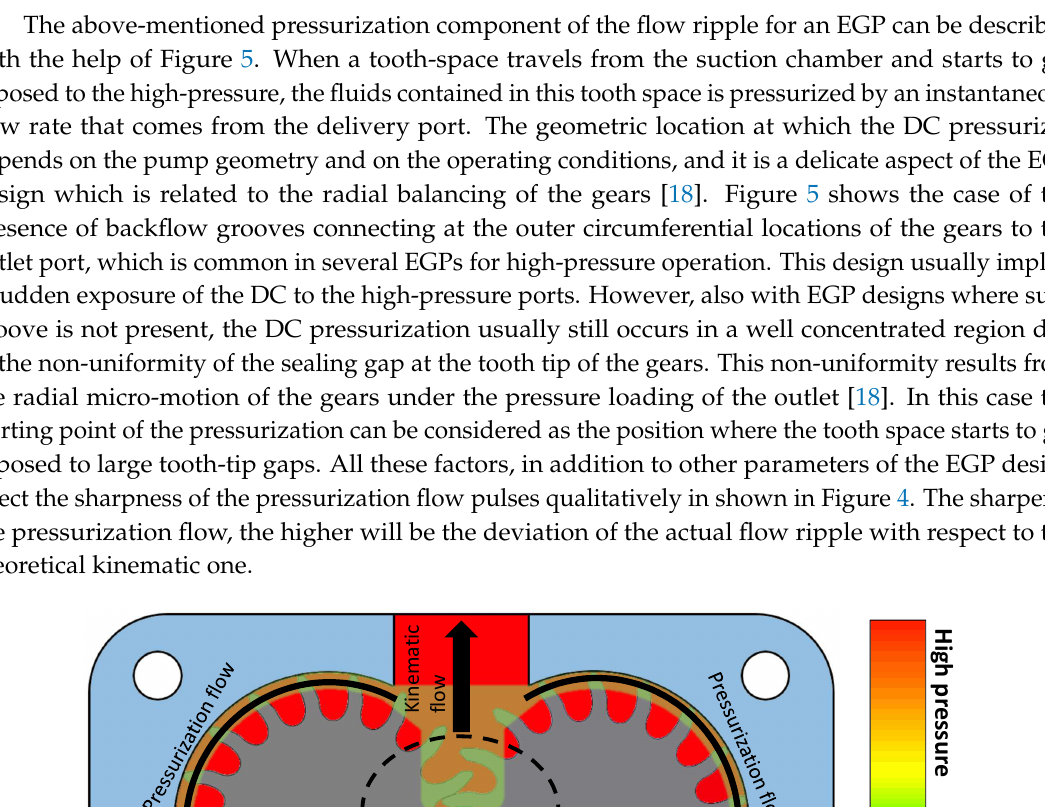
Figure 4. Two major components of the ripple sources: compressibility, and the kinematic flow (dashed line). Produced with the reference pump at 2000 RPM, 200 bar operating condition and VT circuit.